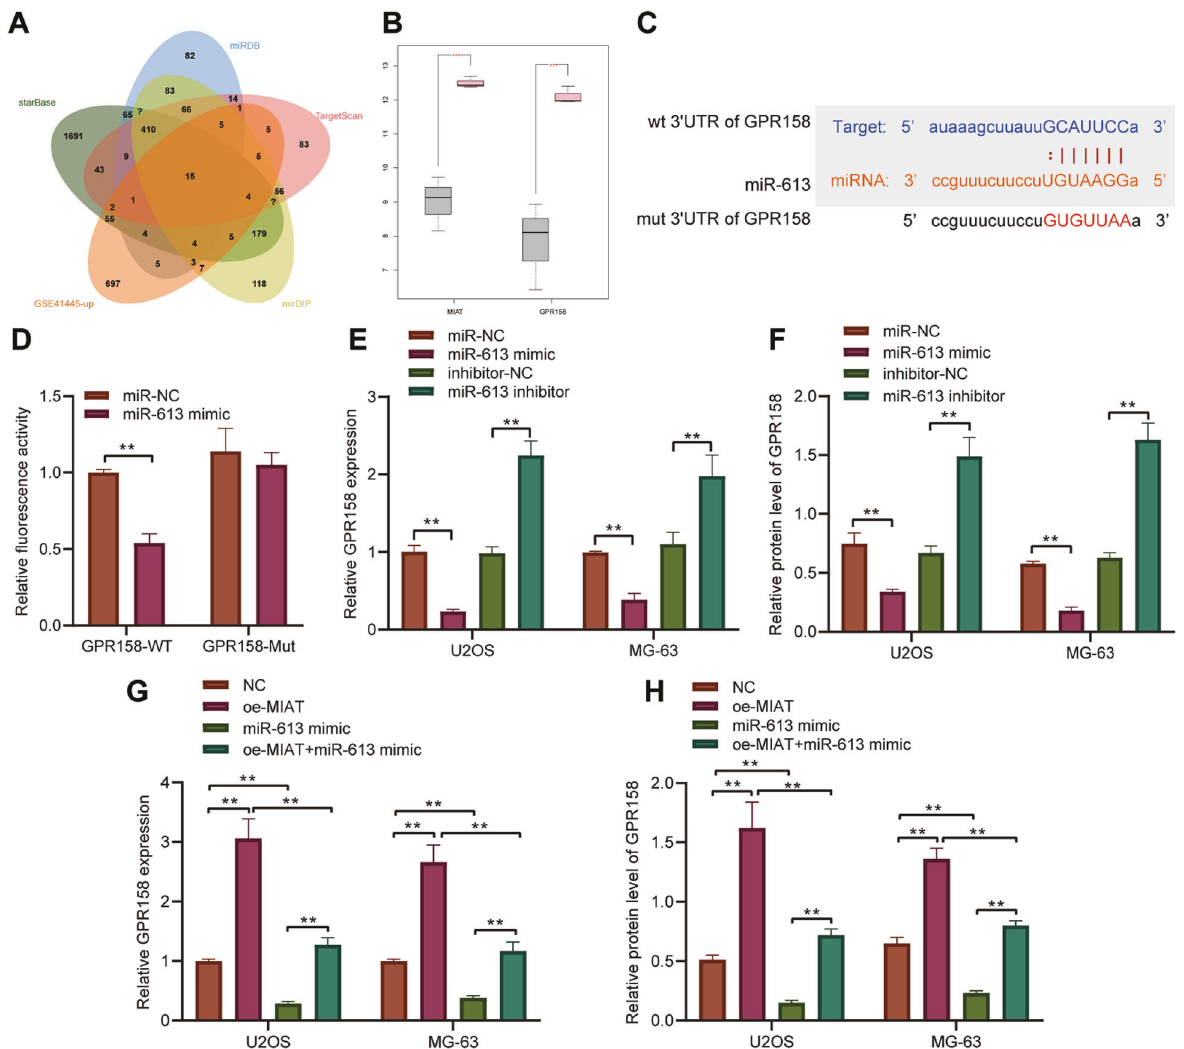
Fig. 5 MIAT increases the expression of GPR158 by competitively binding to miR-613. A Venn diagram analysis of the predicted target mRNAs of miR-613 by starBase, miRDB, TargetScan, and mirDIP databases, and upregulated mRNAs in the GSE41445 dataset. B GPR158 expression in normal and osteosarcoma samples in the GSE41445 dataset. C Predicted binding sites between miR-613 and GPR158 by the starBase database. D Binding of miR-613 to GPR158 con fi rmed by dual-luciferase reporter assay in 293 T cells. E Expression of GPR158 determined by RT-qPCR in U2OS and MG63 cells transfected with miR-613 mimic or miR-613 inhibitor. F Western blot analysis of GPR158 protein in U2OS and MG63 cells transfected with miR-613 mimic or miR-613 inhibitor. G Expression of GPR158 determined by RT-qPCR in U2OS and MG63 cells transfected with oe-MIAT, miR-613 mimic, or both. H Western blot analysis of GPR158 protein in U2OS and MG63 cells transfected with oe-MIAT, miR-613 mimic, or both. * p < 0.05, ** p < 0.01, *** p < 0.001. All experiments were conducted three times Prediction results of the starBase database revealed the presence of binding sites between miR-613 and GPR158 (Fig. 5C). Analysis using the dual-luciferase reporter assay further presented that miR-613 mimic decreased the luciferase activity of WT-GPR158 (Fig. 5D). Besides, a decline of GPR158 expression was seen in osteosarcoma cells transfected with miR-613 mimic, whereas a contrary trend was evident upon miR-613 inhibitor treatment (Fig. 5E, F and Supplementary Fig. 1B). Furthermore, as shown in Fig. 5G, H and Supplementary Fig. 1C, GPR158 expression was elevated in oe-MIAT-transfected osteosarcoma cells but was diminished in miR-613 mimic-transfected osteo- sarcoma cells. Simultaneous overexpression of MIAT and miR- 613 led to lower GPR158 expression than MIAT overexpression alone, while higher GPR158 expression was noted in comparison to single miR-613 overexpression.